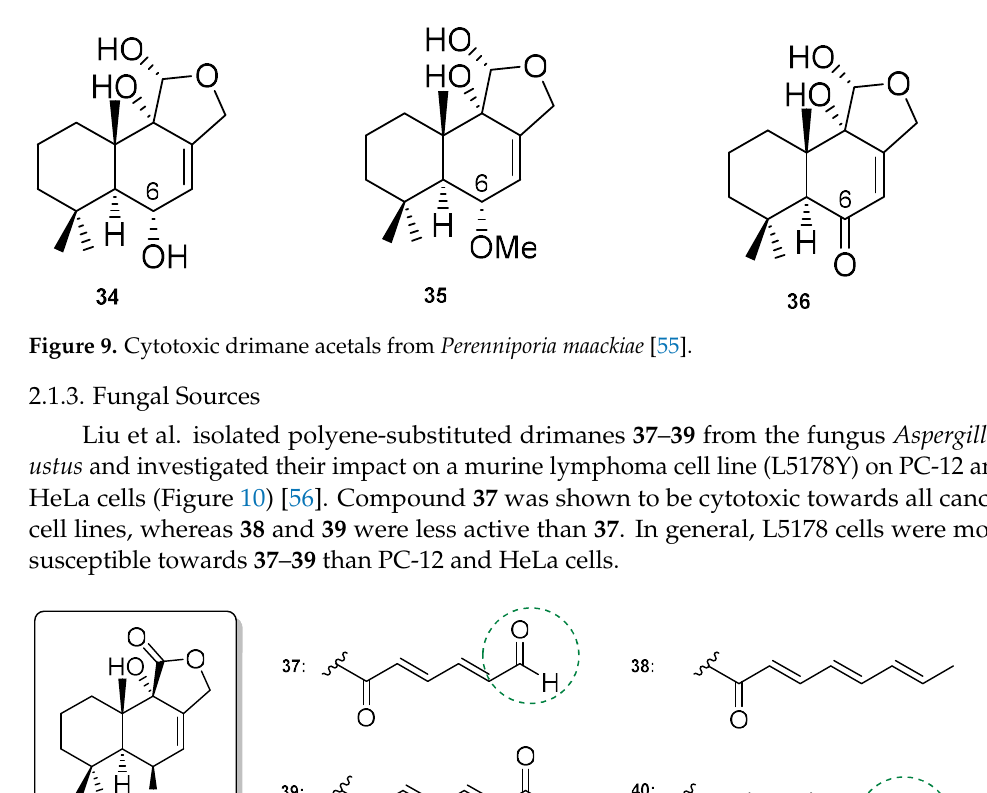
Figure 8. Drimane lactones from Dendrodoris carbunculosa [54].